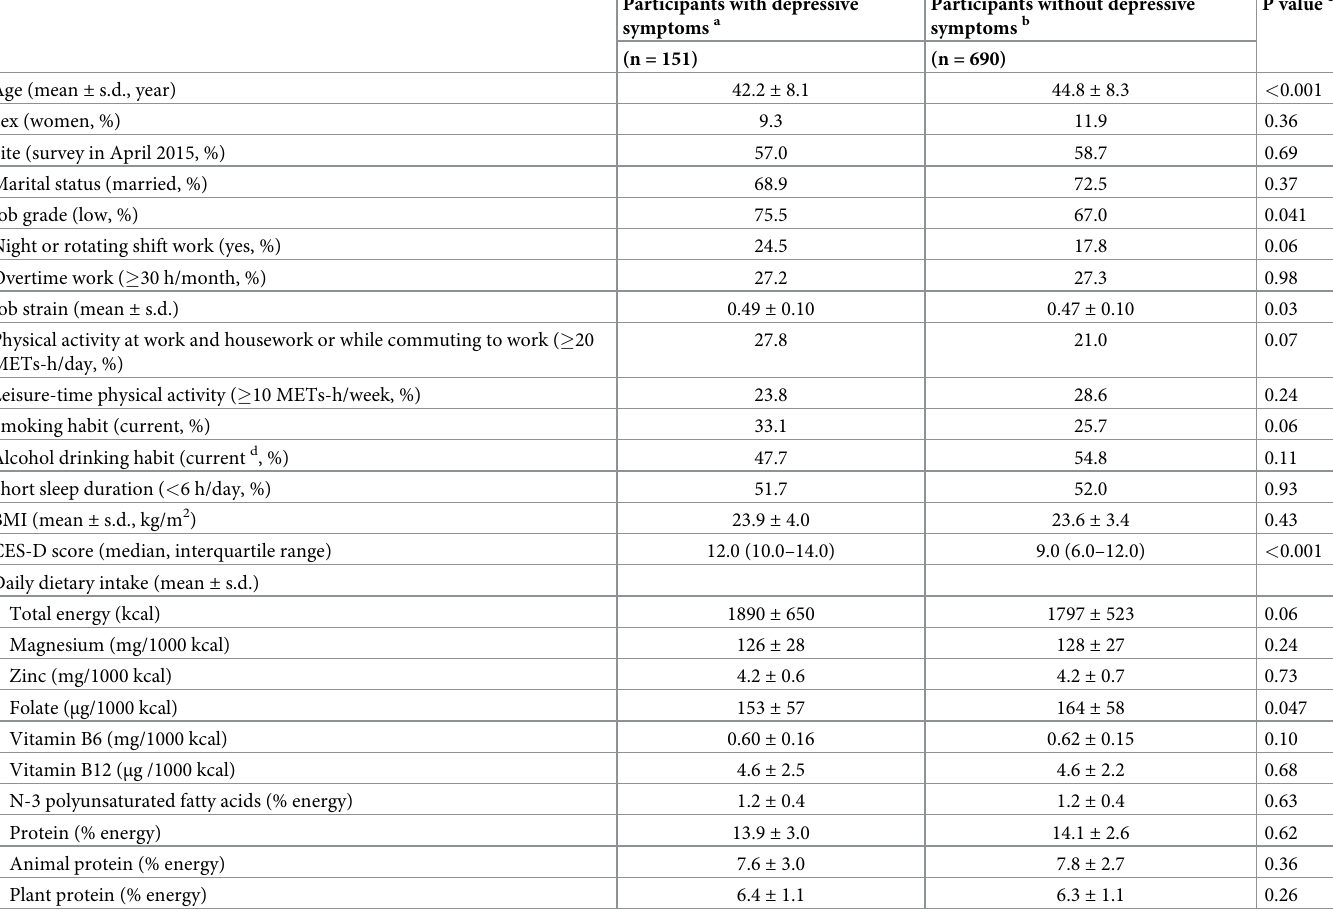
Table 1. Baseline characteristics of study population according to their depressive status at follow-up survey.